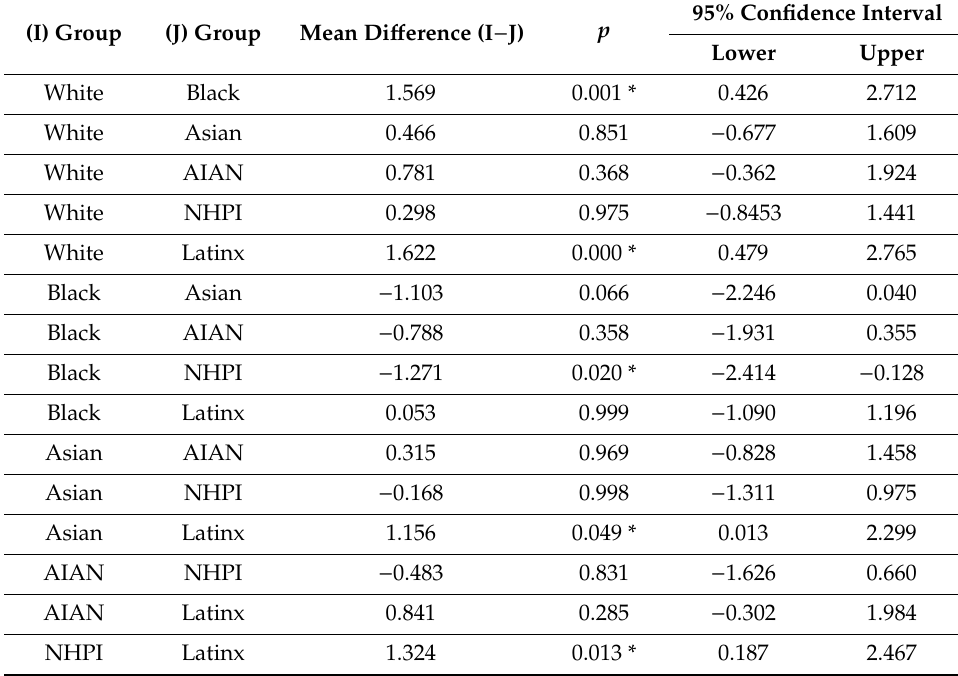
Table A2. Post-Hoc Comparisons for RQ